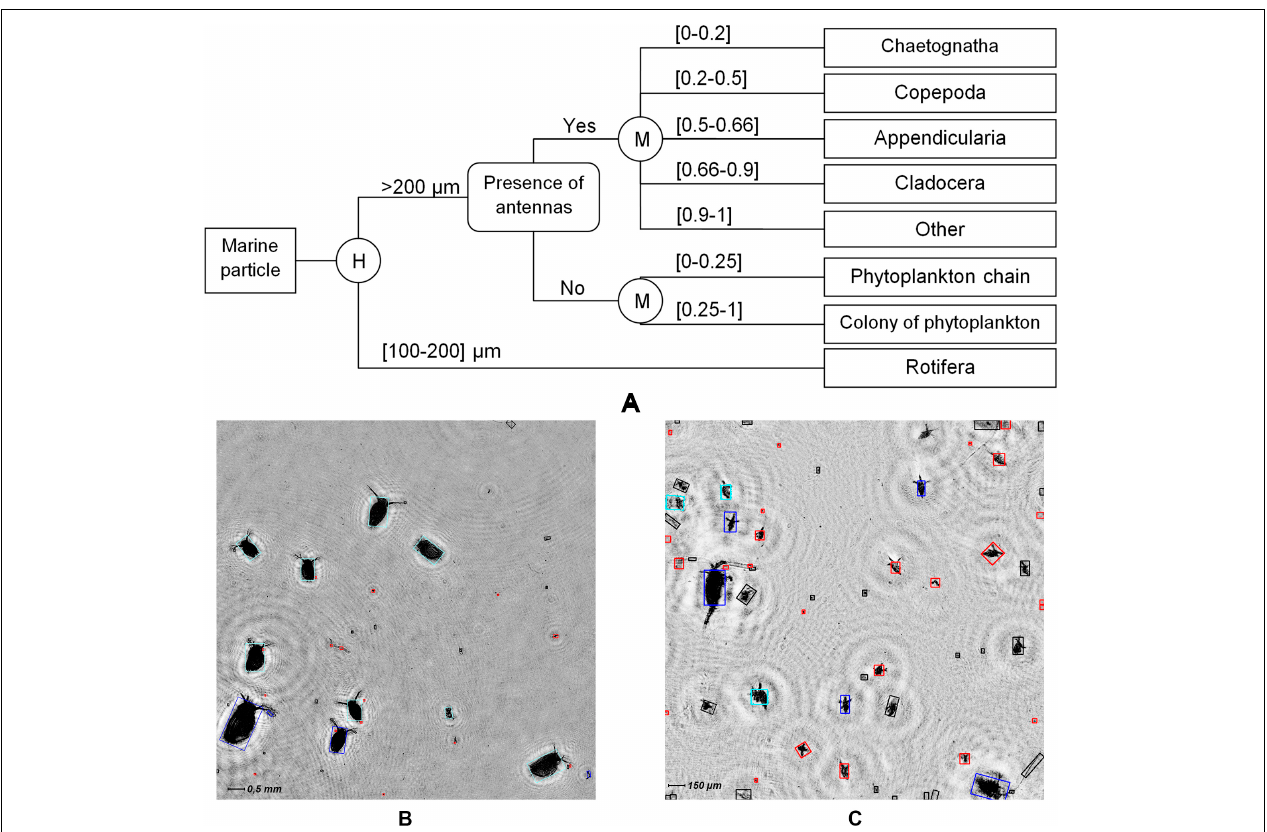
FIGURE 2 | (A) Decision tree of automatic classification of plankton individuals, where M – morphological parameter and H – rectangle length. 2D display of holographic image of the studied volume with (B) Daphnia magna and (C) Epischura baikalensis individuals (nauplii and adult specimen), where the result of automatic classification is marked with the color of the rectangle circumscribed around the particle: black – phytoplankton colonies, dark blue – Copepoda , blue – Cladocera , and red –